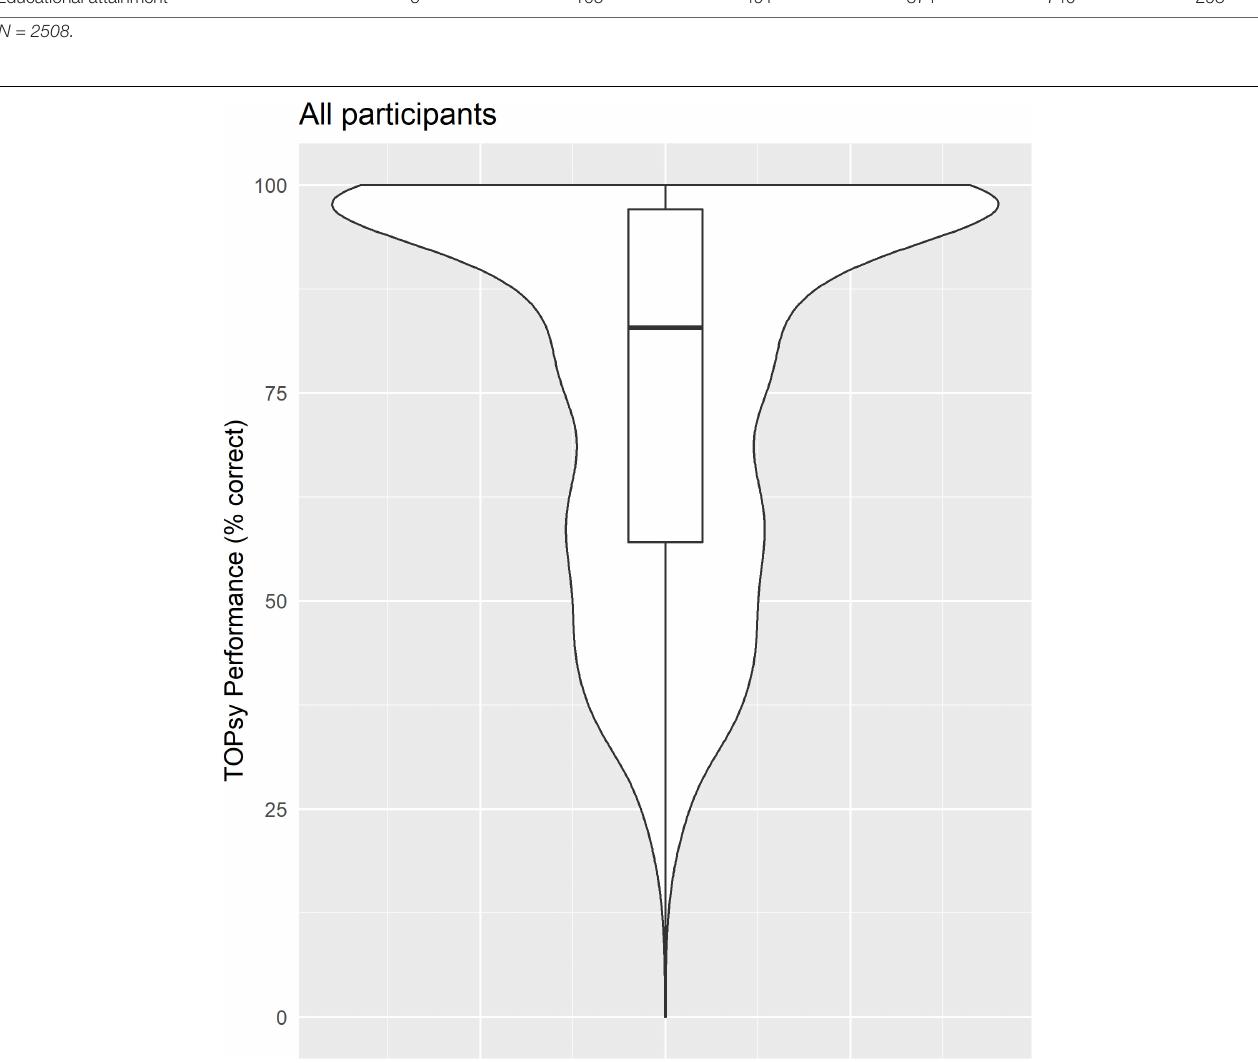
FIGURE 1 | Variability in speech rhythm perception in the sample, as measured by TOPsy scores, is illustrated as percentage correct on the 35-item test. Scores ranged from 11.4% to 100%, with a median score of 82.9%. Box plot indicates interquartile ranges around the median.